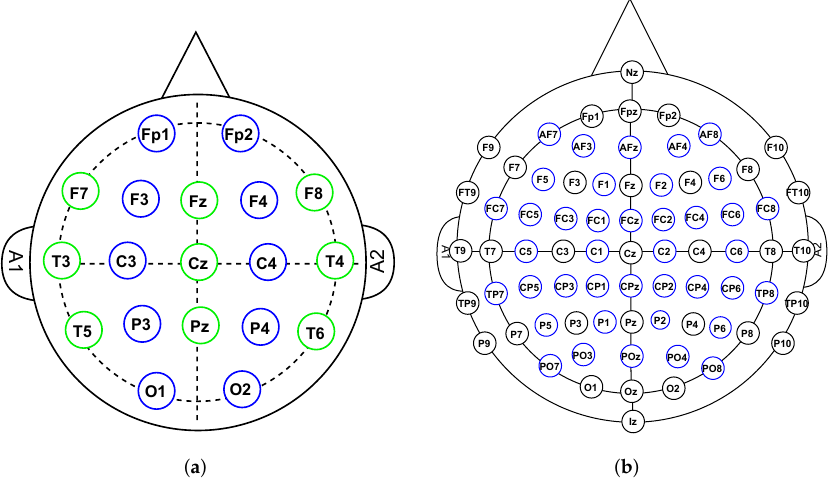
Figure 1. The spatial location of electrodes according to standard systems. Each electrode is located by a letter and a number. The letter expresses the brain cortex for the electrode location: frontal (F), central (C), parietal (P), Occipital (O), temporal (T), and frontoparietal (FP). Even numbers are used for the brain’s right hemisphere, while odd numbers are for the brain’s left hemisphere. ( a ) the 10–20 International system; ( b ) the 10–10 International